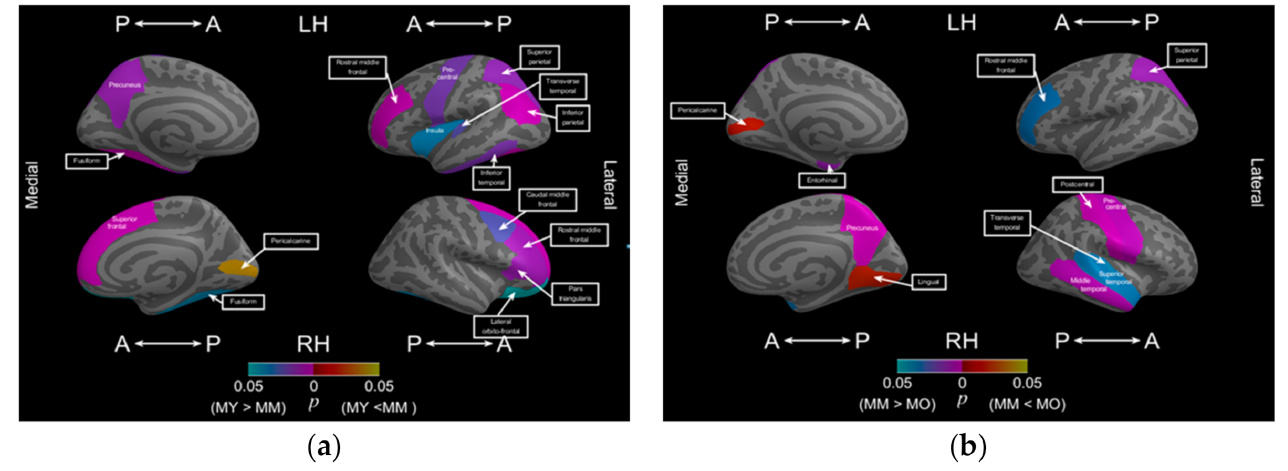
Figure 5. Significant decrease in FD values in the subregions in men between different age stages. ( a ) Significant decrease in FD values in the subregions in men in the young-age group compared with that in men in the middle-age group; ( b ) decrease in fractal dimension (FD) values in the subregions in men in the middle-age group compared with that in men in the old-age